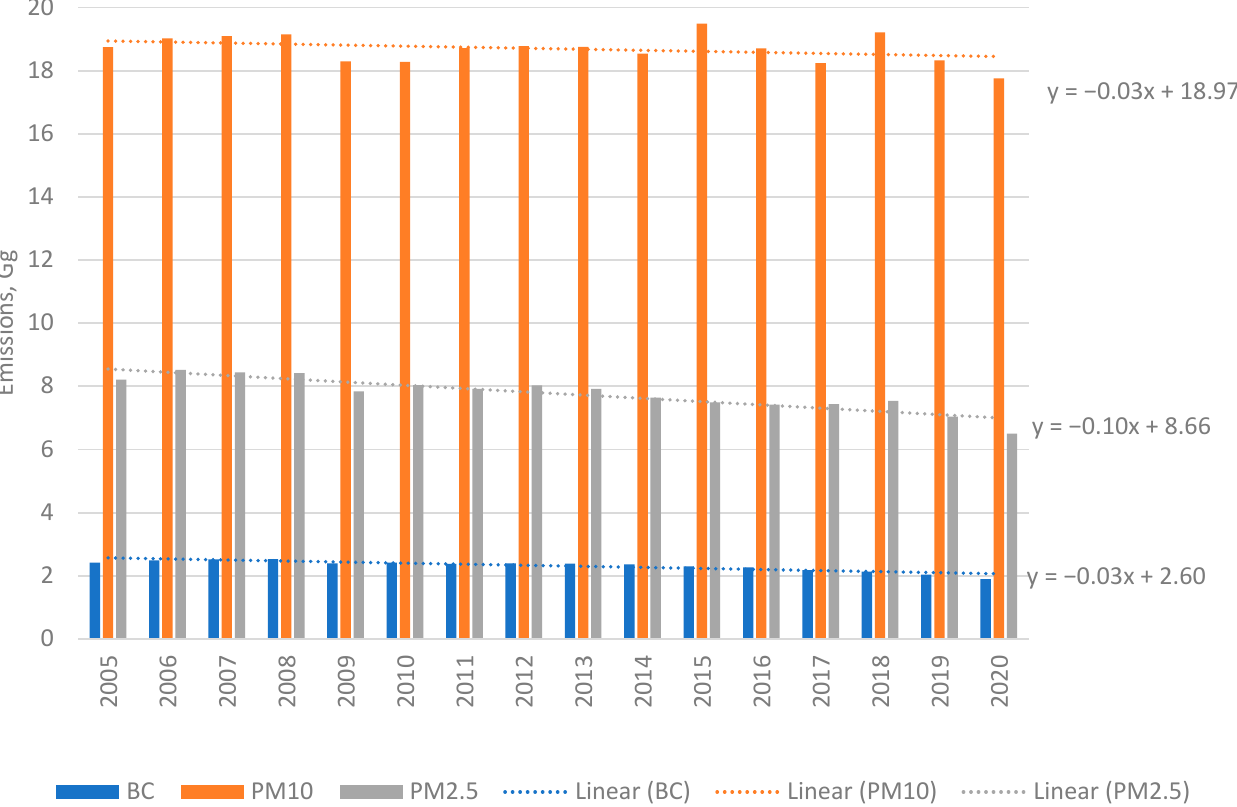
Figure 4. PMs’ national emissions for Lithuania in 2005–2020.